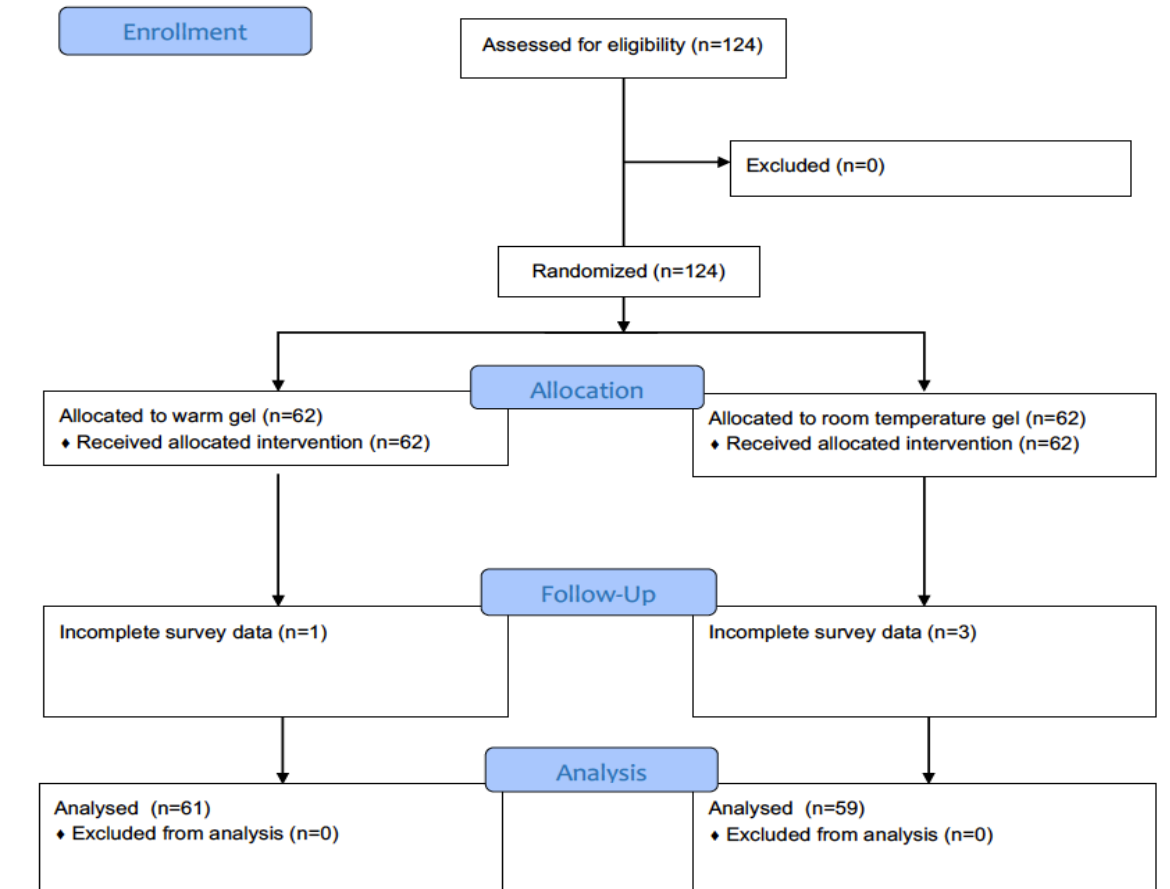
Figure. Consort 2010 Flow Chart. Patient trial participation in study examining patient satisfaction as related to temperature of ultrasound